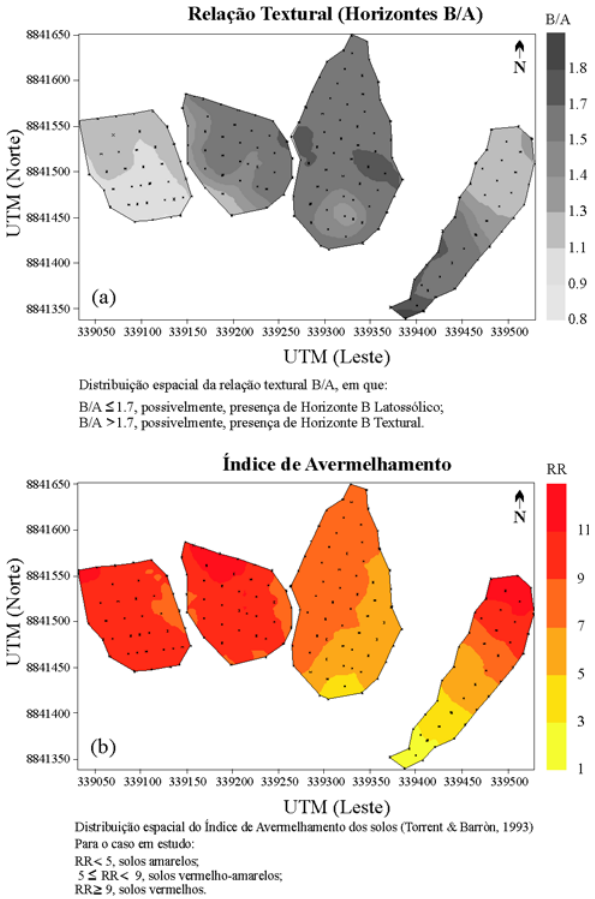
Figura 5. Mapas interpolados por krigagem ordinária, demonstrando a distribuição espacial dos atributos: (a) relação textural-B/A e (b) índice de avermelhamento-RR na profundidade de 40-60